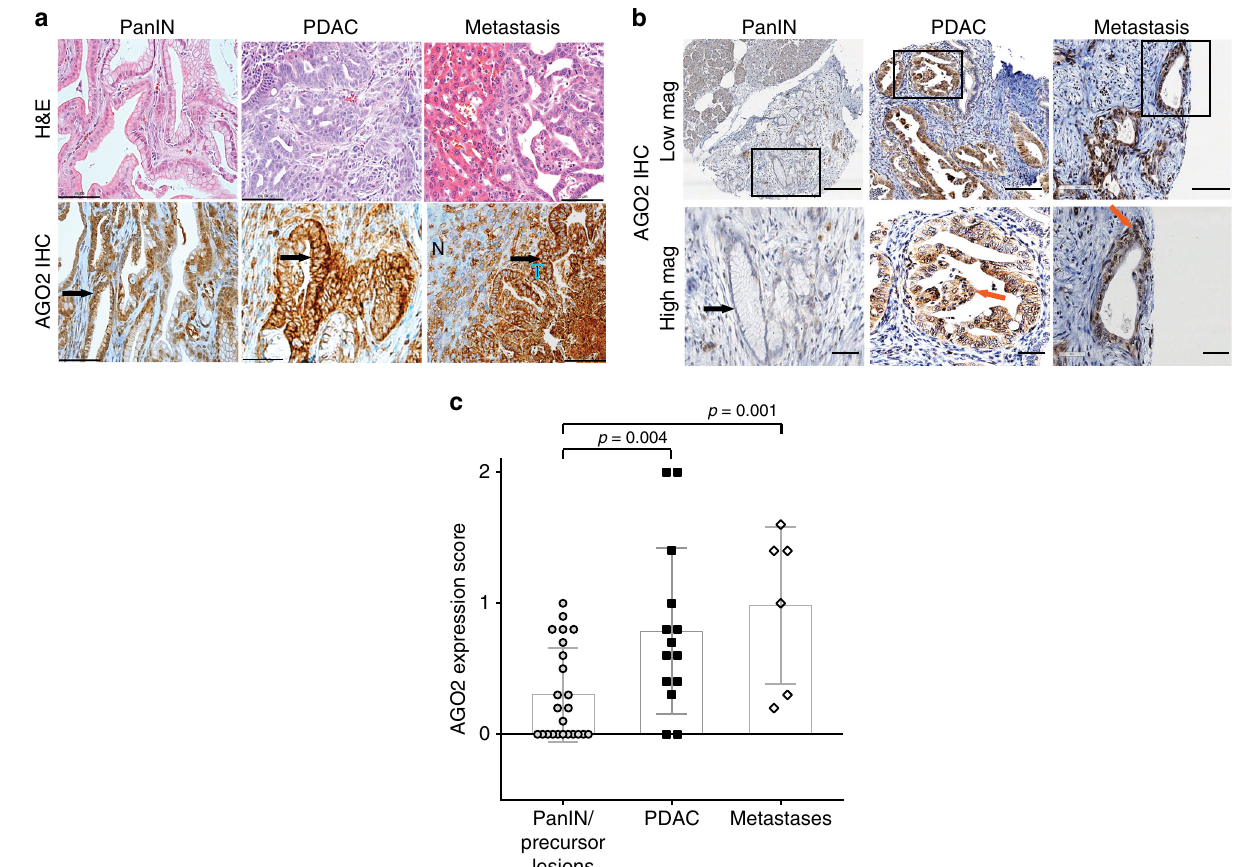
Fig. 4 Increased AGO2 expression during mouse and human PDAC progression. a Representative images of AGO2 IHC analysis within an individual AGO2 + / + ;KRAS G12D ; p48Cre mouse showing increased AGO2 expression in PDAC and metastasis compared with PanIN lesions. Arrows point to PanIN, PDAC, or metastatic PDAC in respective panels. In the metastasis panel, N = normal liver and T = tumor. Scale bar, 40 µ m. b Representative images of IHC analysis for AGO2 expression in human PDAC progression showing elevated AGO2 protein expression in PDAC and metastatic tissue. Lower panels show higher magni fi cations of areas marked in the upper panels. Scale bars in the top and bottom panels are 200 and 80 µ m, respectively. Arrows point to PanIN and PDAC. c Box and scatter plot showing AGO2 expression on a human tissue microarray (TMA) containing 44 human pancreatic tissue samples (24 precancerous, 14 PDAC, and six metastatic PDAC lesions), as determined by IHC analysis. Each sample was scored for intensity of stain and percent tumor cells staining for AGO2, and the fi nal score = intensity × percent positive cells. p values were determined using a two sided t -test. Data are presented as mean values + / −